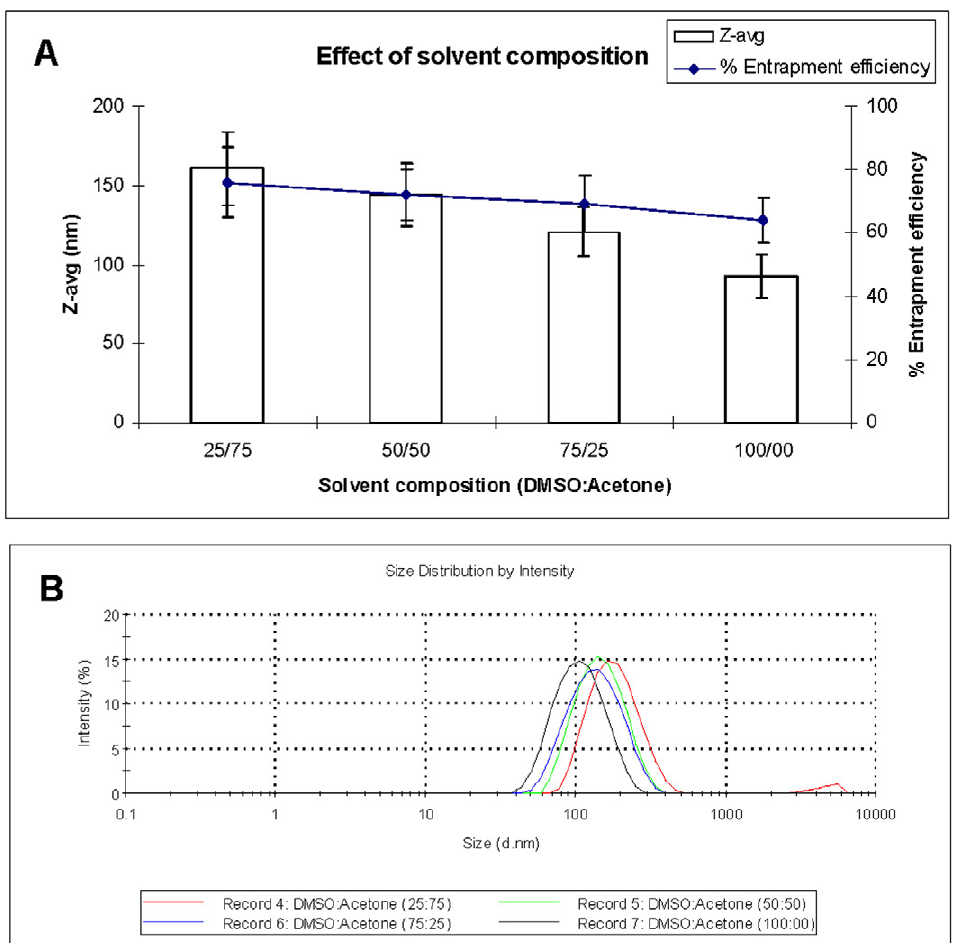
Figure 2. The effect of solvent composition (DMSO:acetone) on particle size, entrapment efficiency (A) and particle size distribution (B). For all the preparations, PDI is 0.1 6 0.01.